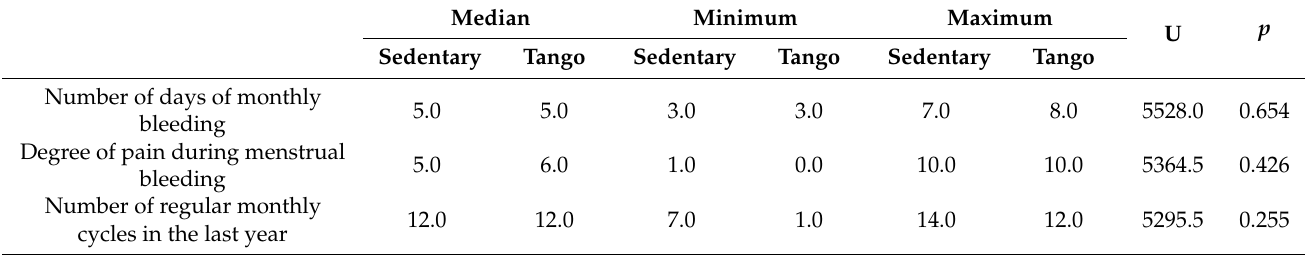
Table 3. Characteristics of the menstrual cycle—parametric value.